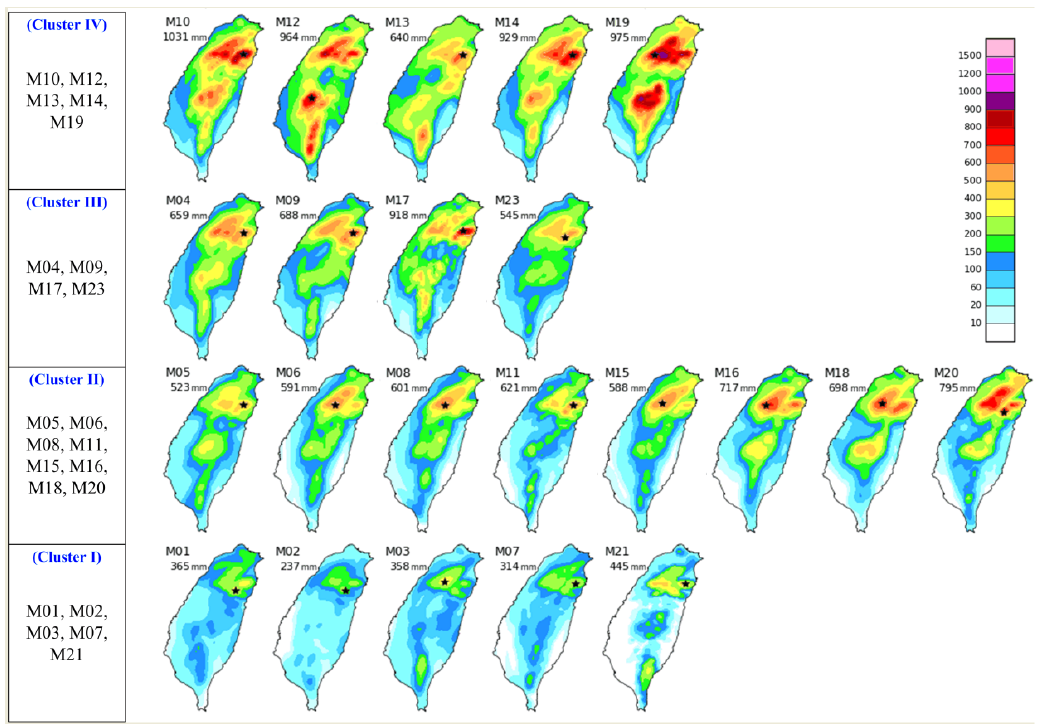
Figure 6. Results provided by the SOM-based cluster analysis technique (Typhoon